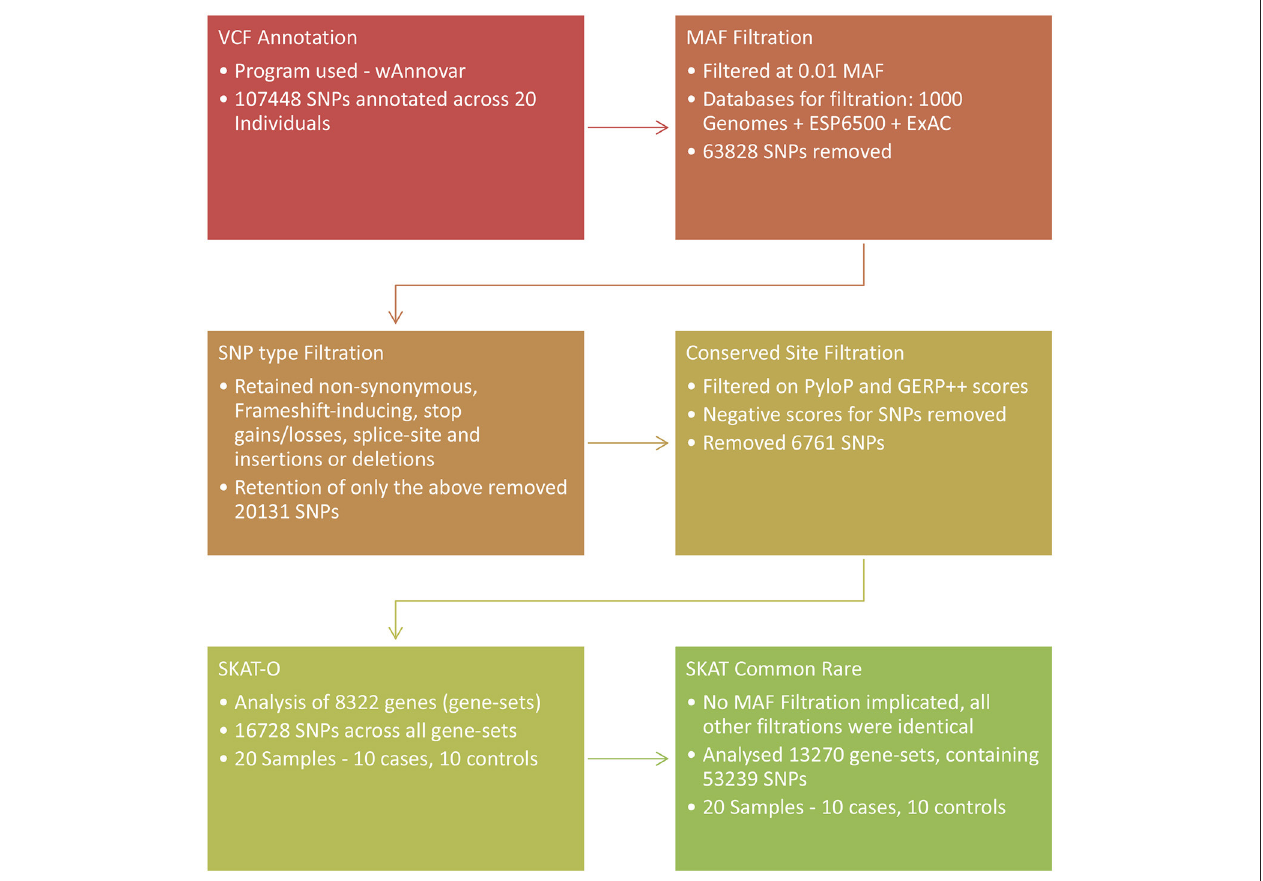
FIGURE 1 | Overview of the SNP prioritization procedures followed and association analyses used in the exome sequencing arm of the study. SKAT, Sequence Kernel Association Test.